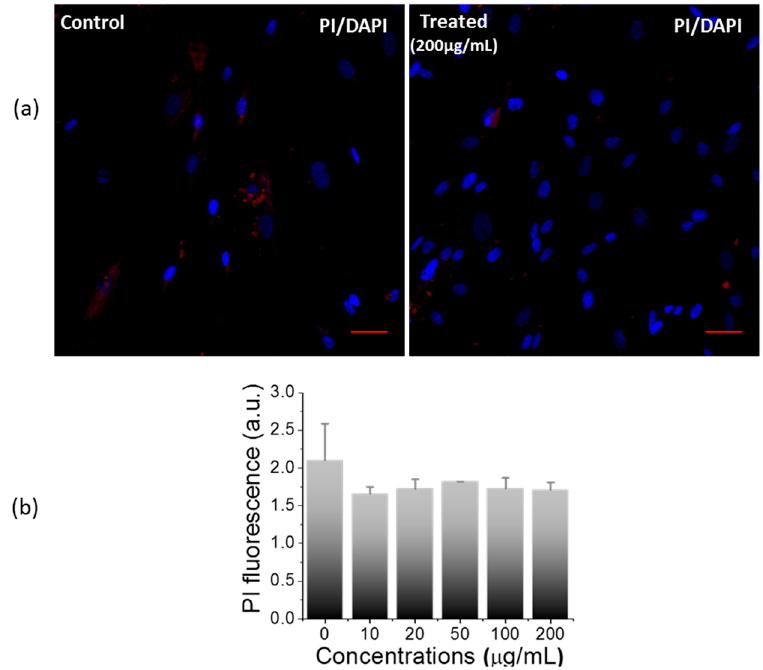
Figure 5. Impact of nanosheet on cell cytotoxicity. ( a ) Confocal images of PI staining for evaluation of nanosheet mediated cell cytotoxicity (scale bar: 50 µm), ( b ) Cytotoxicity assessment by quantitative estimation of PI between control and treated cells (200 µg/mL).